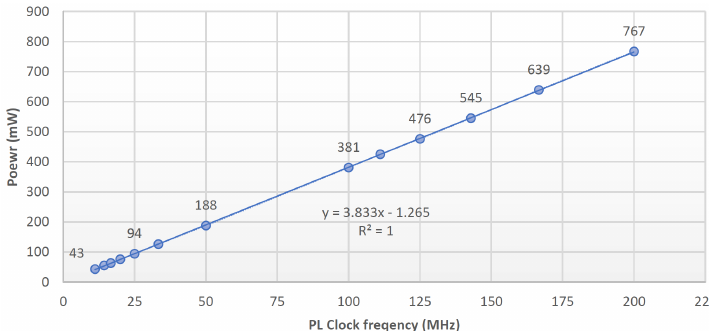
Figure 10. Inference (PL) Power Consumption at various clock frequencies.